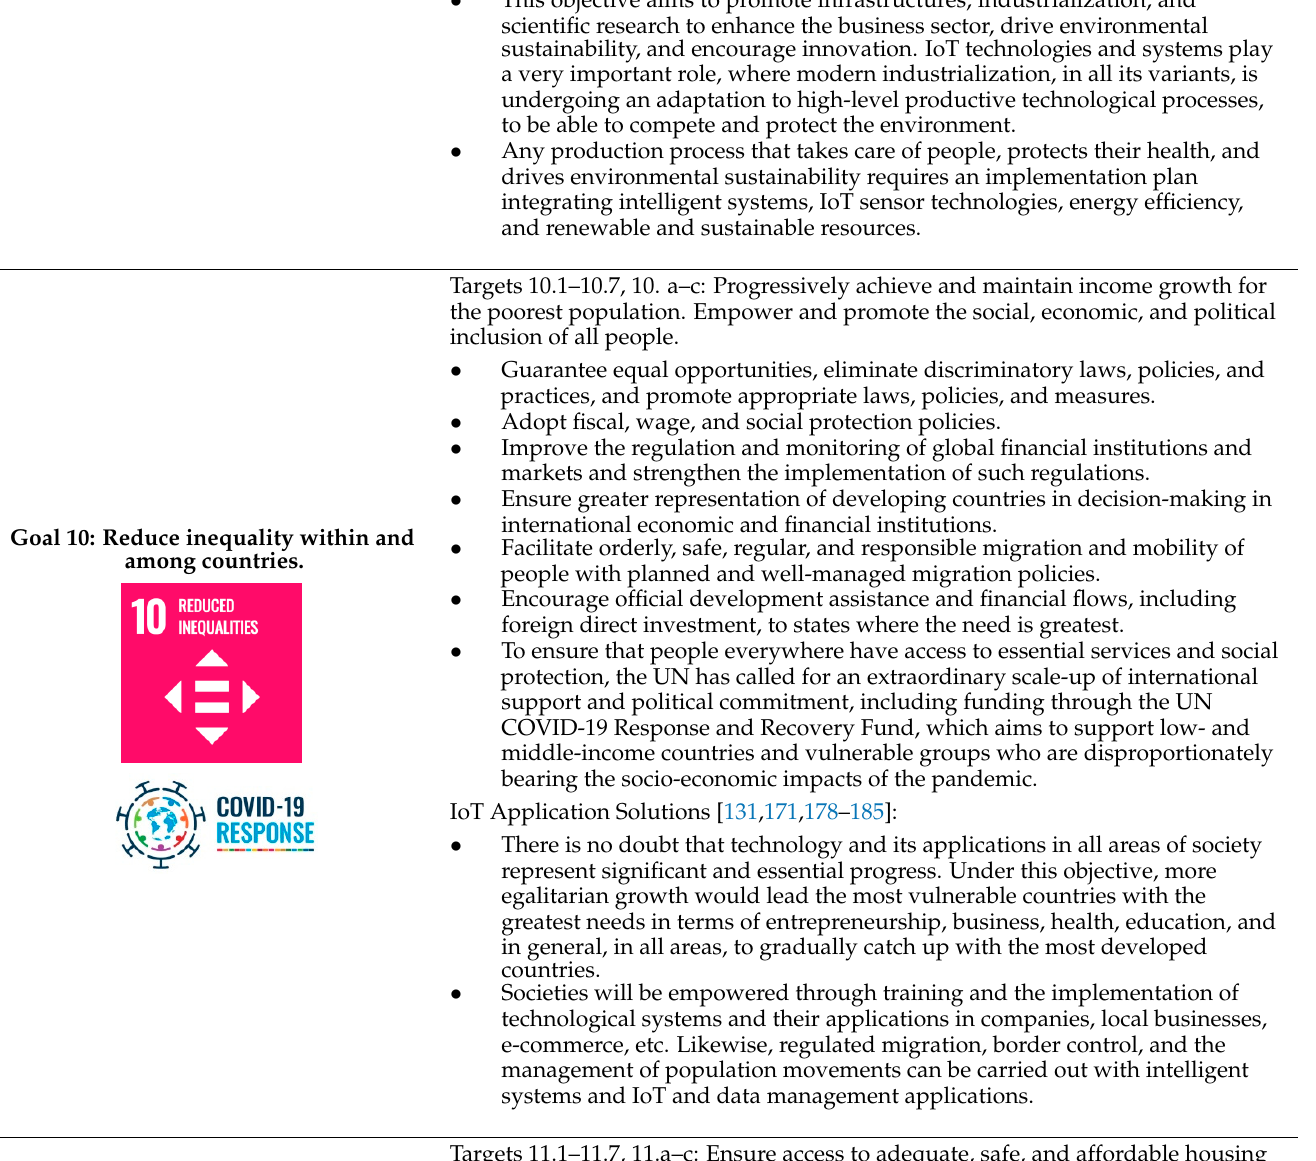
Goal 1: End poverty in all